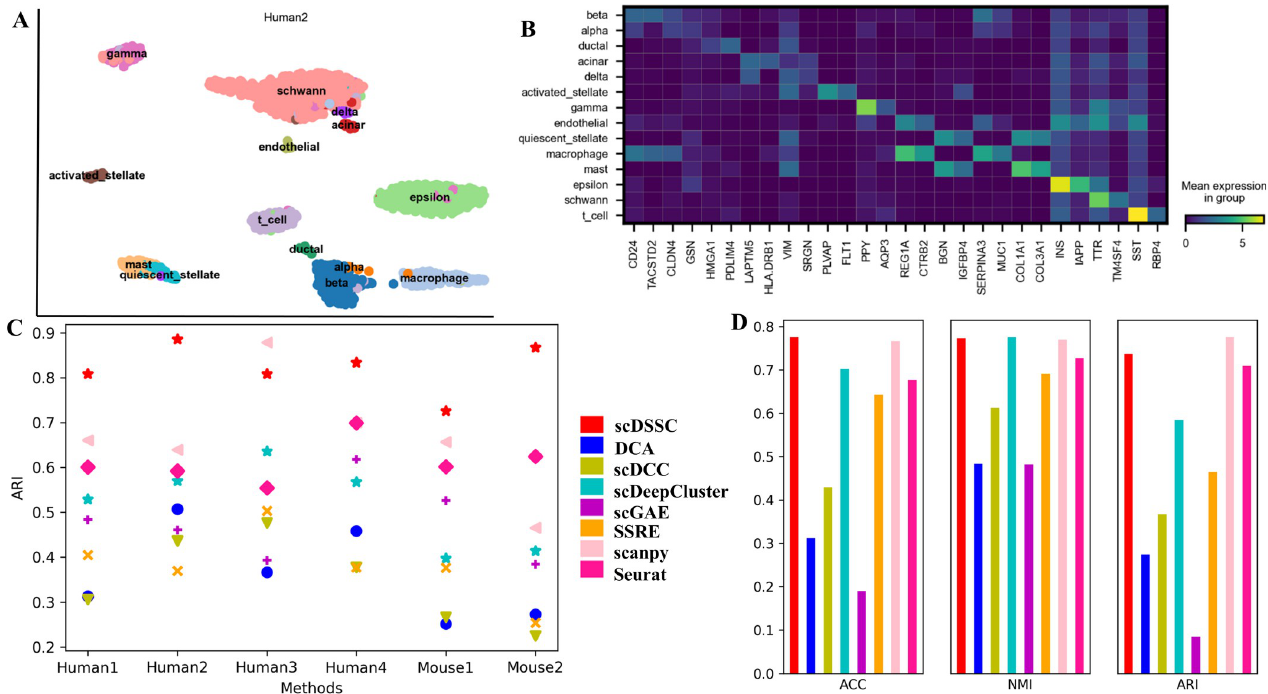
Fig 5. scDSSC is scalable and robust for batch effect. Plot A represents the cell visualization result of Human2 dataset, in which the 14 names indicate 14 different cell types. And plot B is the results of differential expression analysis on Human2. The rows and columns indicate the gene names and cell type names, respectively, and the brightness of the color reflects the average expression of the gene. In Plot C, we used ARI to evaluate the clustering performance of eight methods on six small datasets containing batch effects. Plot D shows the performance of scDSSC assessed by ACC, NMI and ARI on a large dataset Macosko_mouse. Plot C and Plot D use the same